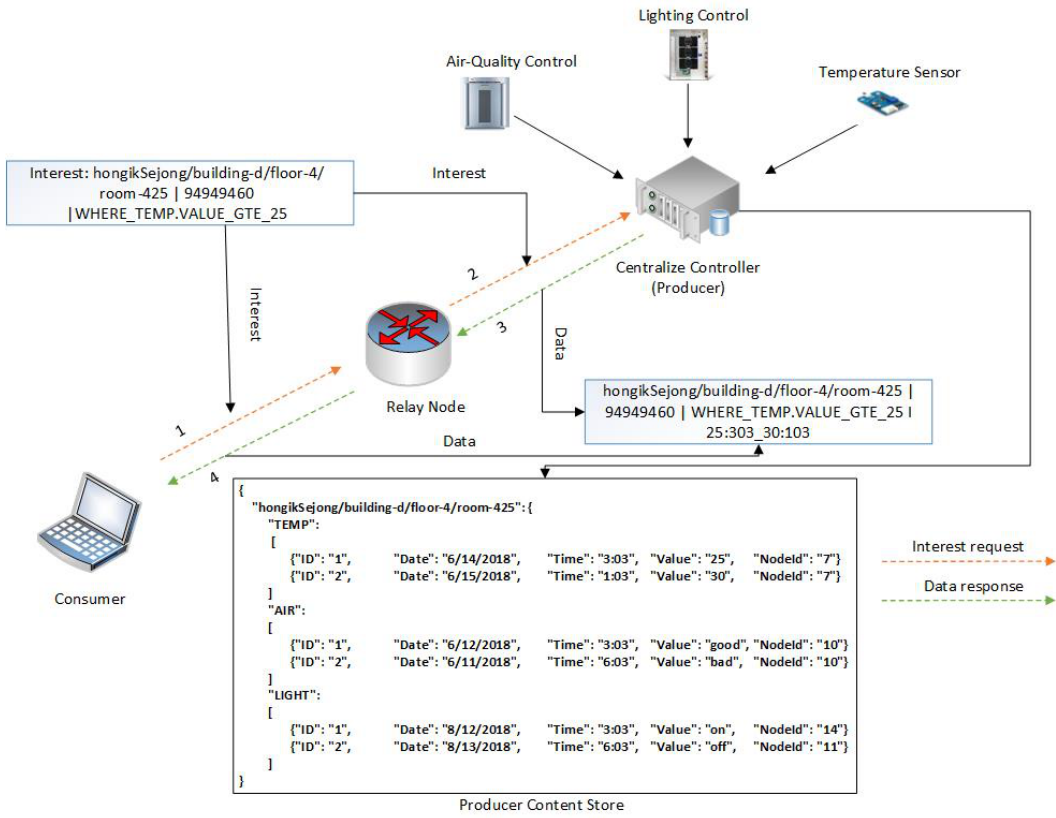
Figure 5. Pull service